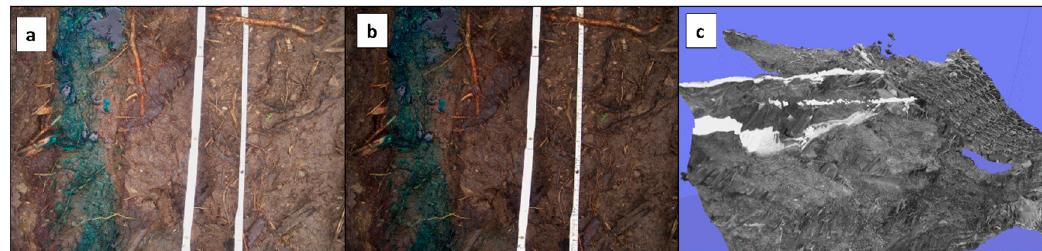
Figure 8. Application of contrast to enhance details. ( a ) and ( b ) contrast enhancement; ( c ): data results.